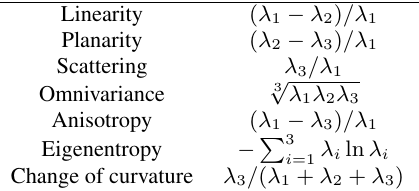
Table 1: 3D features of points